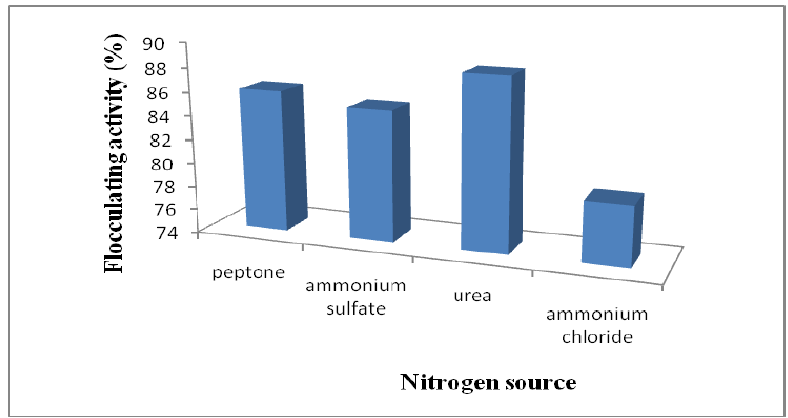
Figure 4. Effect of nitrogen source on flocculating activity of Halomonas sp. OKOH